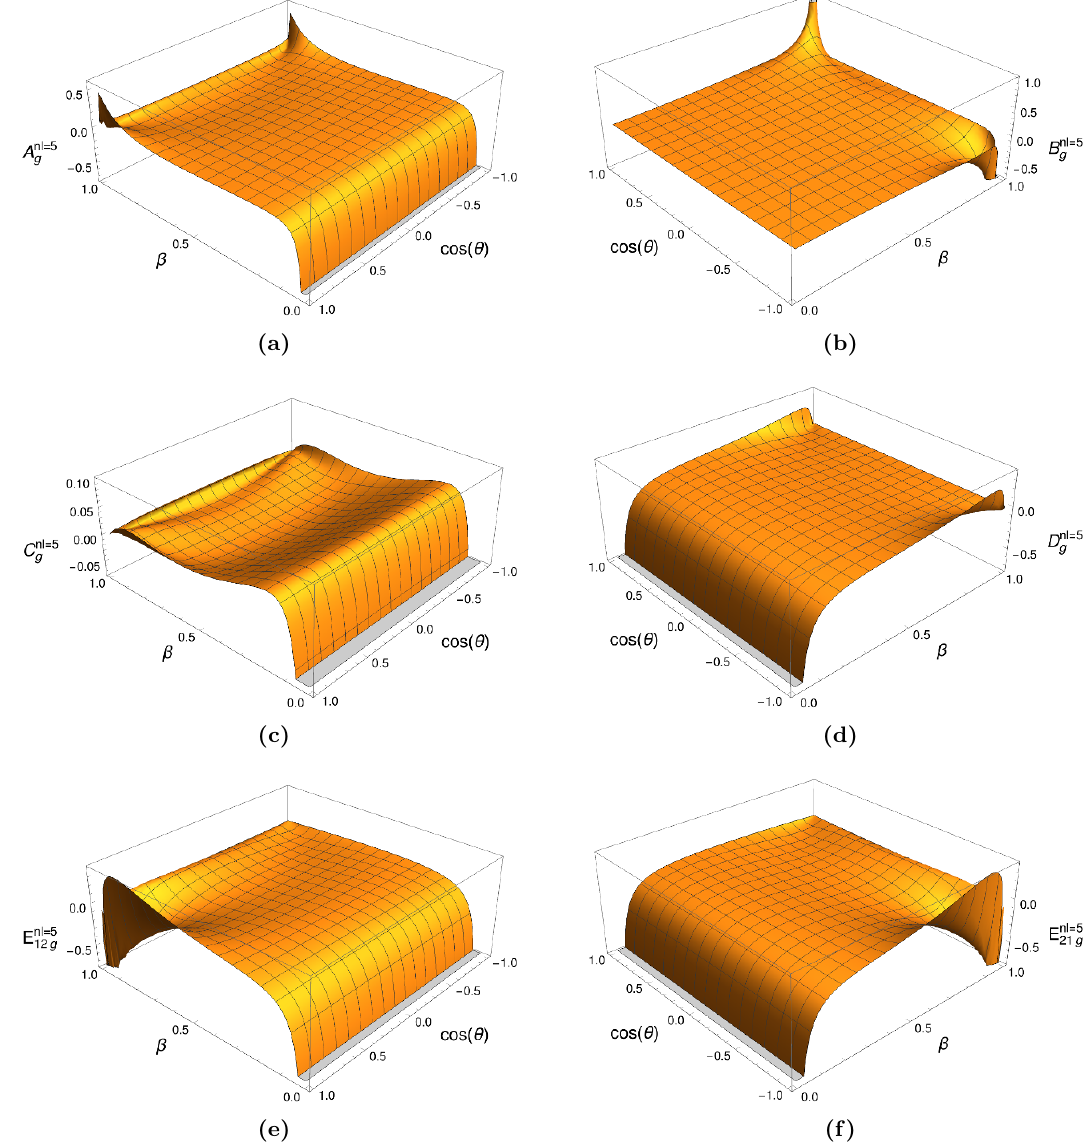
Figure 2 . Finite remainder coe(cid:14)cient functions of the spin-density matrix in case of initial state gluons for n = l